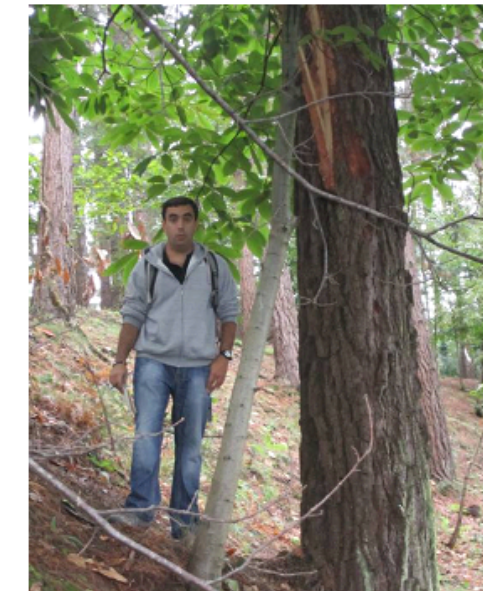
by the discharge covers it from the tip to the bottom, leav- ing a double strip over the bark. This was a live tree, and the bark was wet due to the rainfall. The pass of the lightning current caused the breaking of the bark and the double strip that remains over the